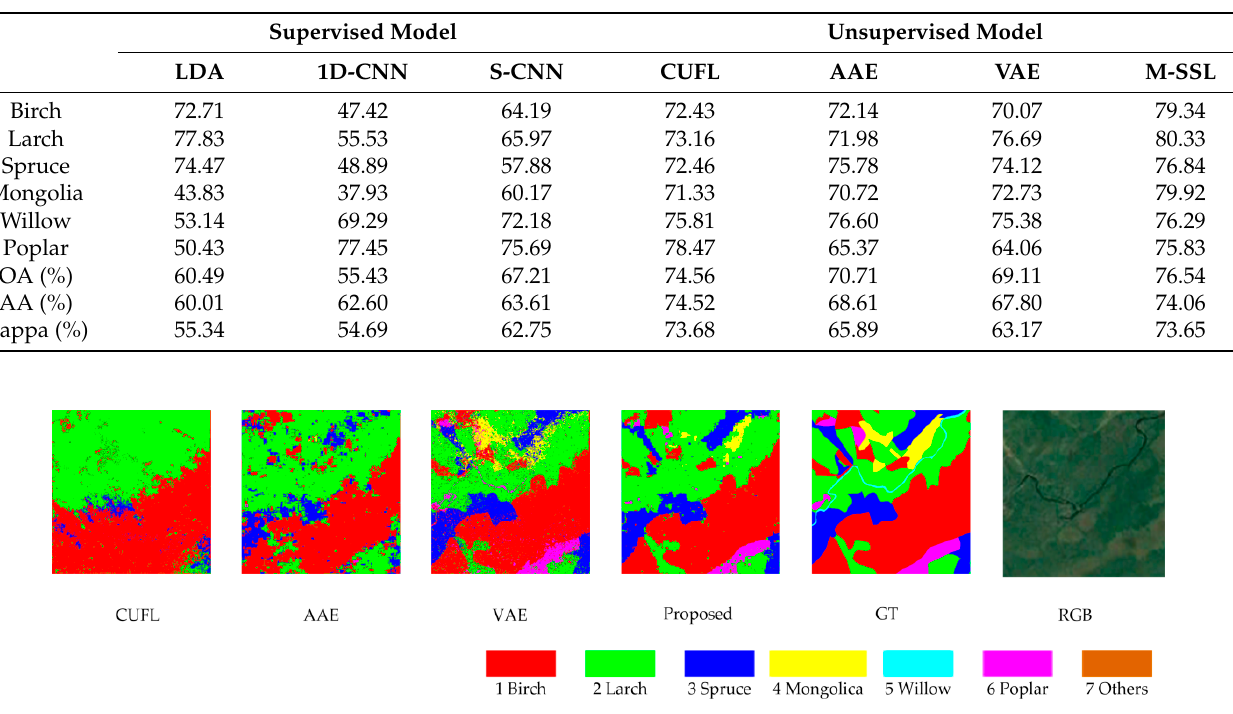
Figure 8. Tree classification maps of models for dataset (3).